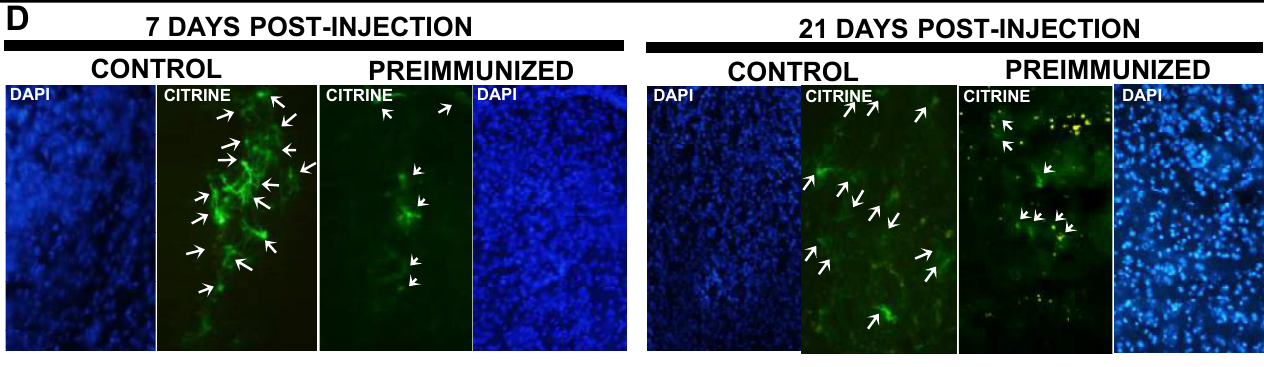
mice were injected i.p with BV.dTomato (10 8 PFU), 30 and 15 days before administration of BV.citrine